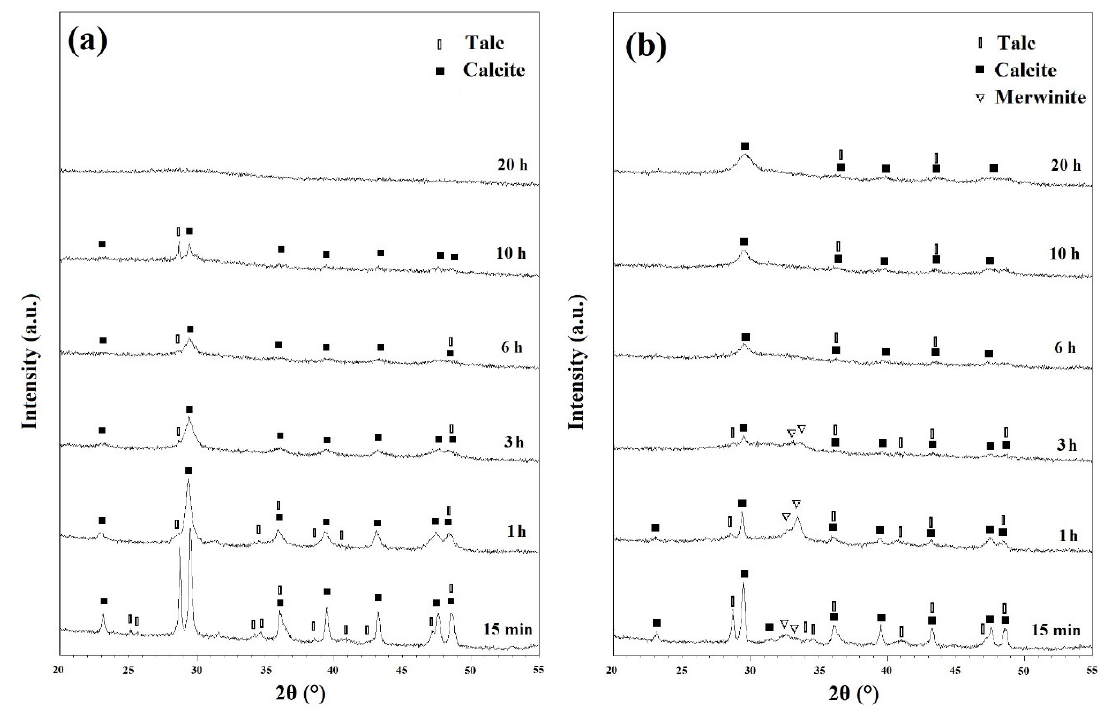
Figure 2. XRD patterns of ball milled powders ( a ) before and ( b ) after subsequent annealing at 700 °C for 1 h.